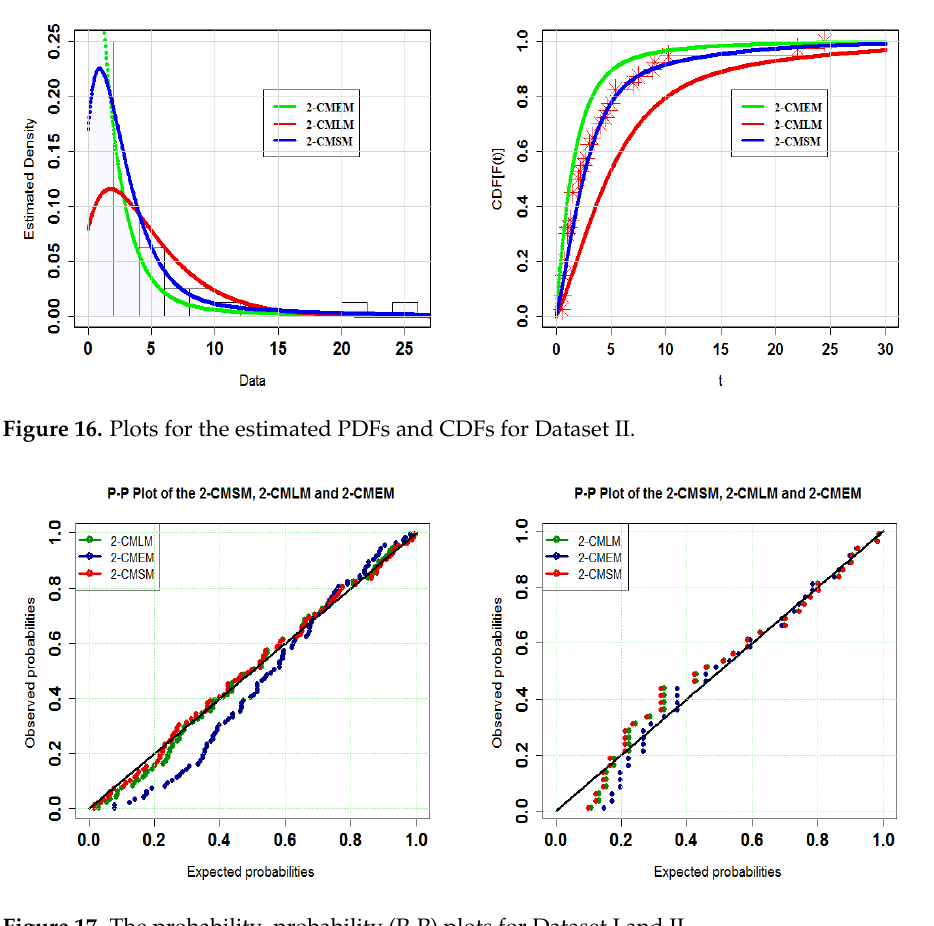
Fig. 17. The probability(cid:150)probability (P-P) plots for Dataset I and II. Figure 17. The probability–probability (P-P) plots for Dataset I and II.